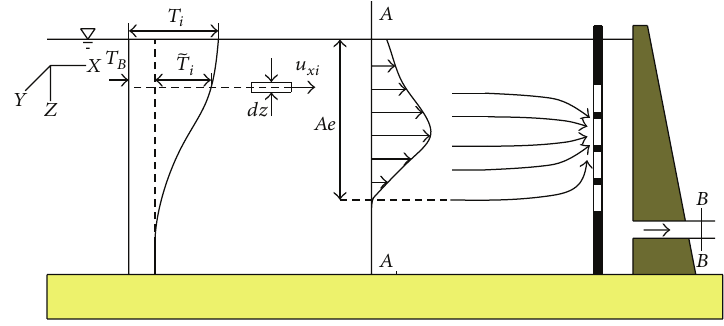
Figure 5: Schematic of velocity field.